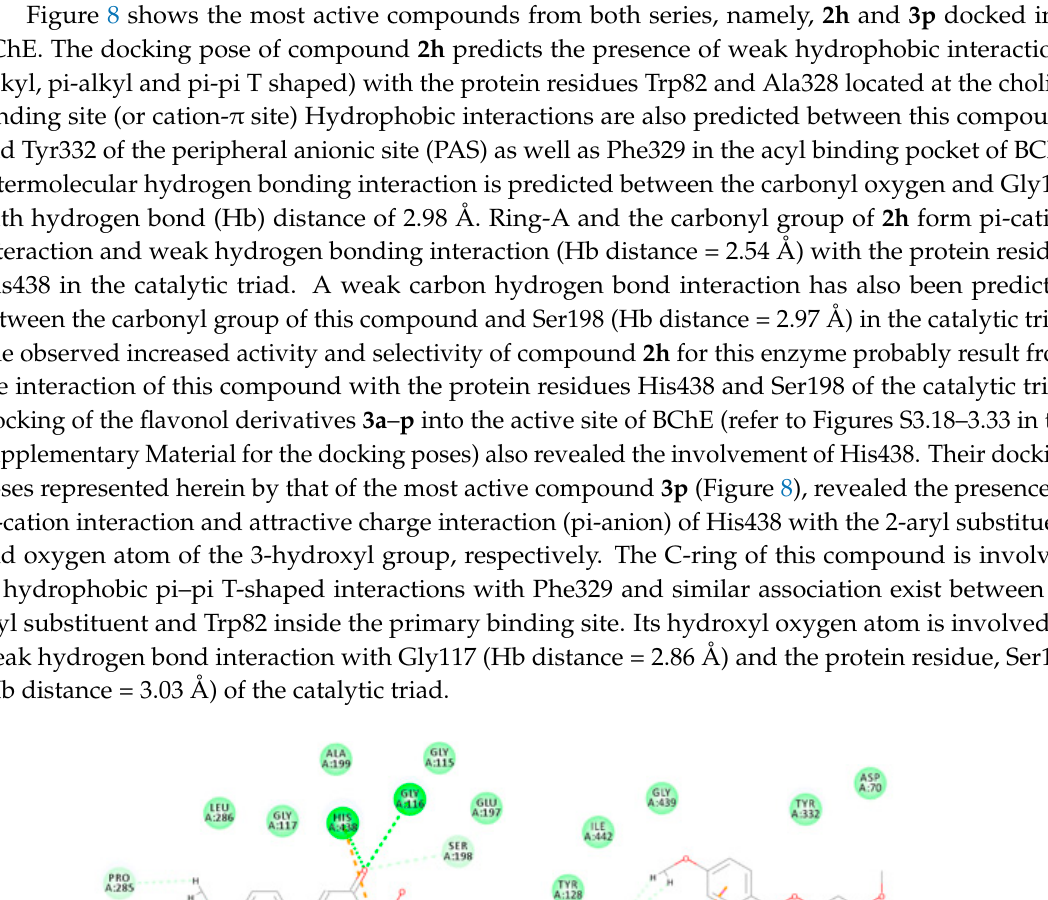
Figure 7. Docking poses of 2f and 3b into the active site of AChE. Interactions are color coded, bright green represents conventional hydrogen bonds, light green ‐ van der Waals interactions, very light green ‐ carbon hydrogen bonds, orange ‐ salt bridges, blue ‐ halogen bonds, dark pink ‐ pi–pi interactions, light pink ‐ pi ‐ alkyl interactions, purple ‐ pi ‐ sigma interactions and green yellow ‐ pi lone pair interactions.